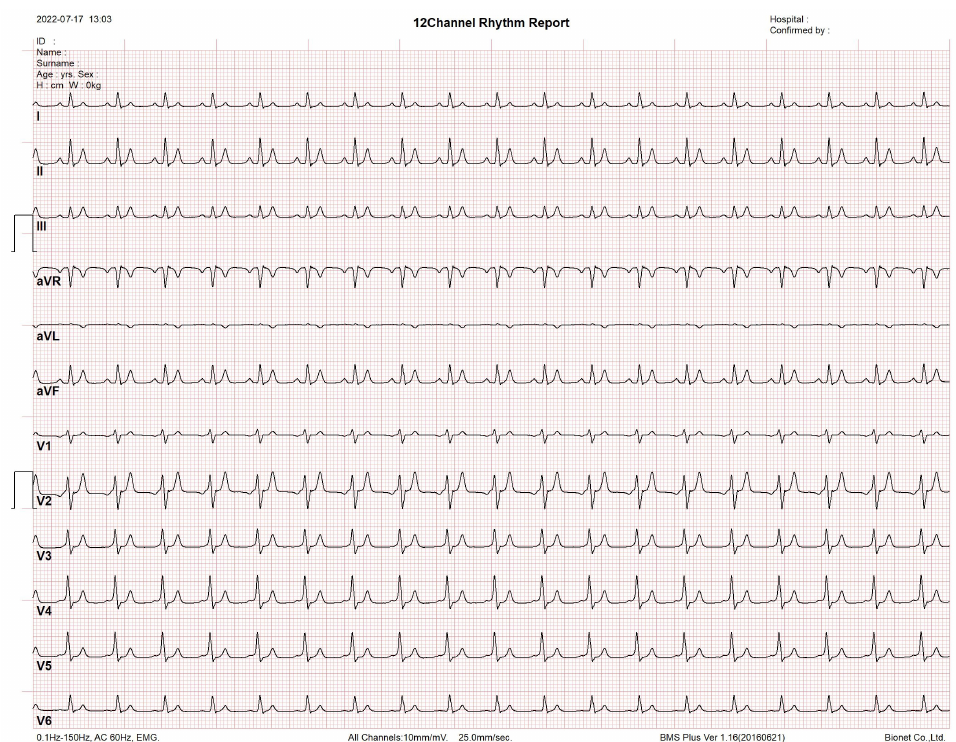
Figure 4. Synthetic 12-lead ECG profile tested using an interpretive 12 channel electrocardiogram machine with series CardioCare 2000.